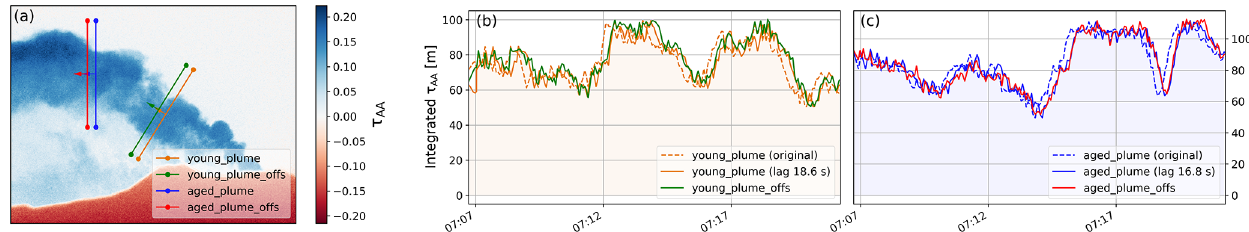
Figure B2. Result of velocity cross-correlation analysis for the Etna data. (a) Example plume AA image including two PCS lines (orange and blue) and corresponding offset lines (green and red) used for the analysis. (b, c) Corresponding time series of the integrated AA values along the two PCS lines (original: dashed, shifted using correlation lag: solid) and along the offset lines (solid) using the same colour scheme.